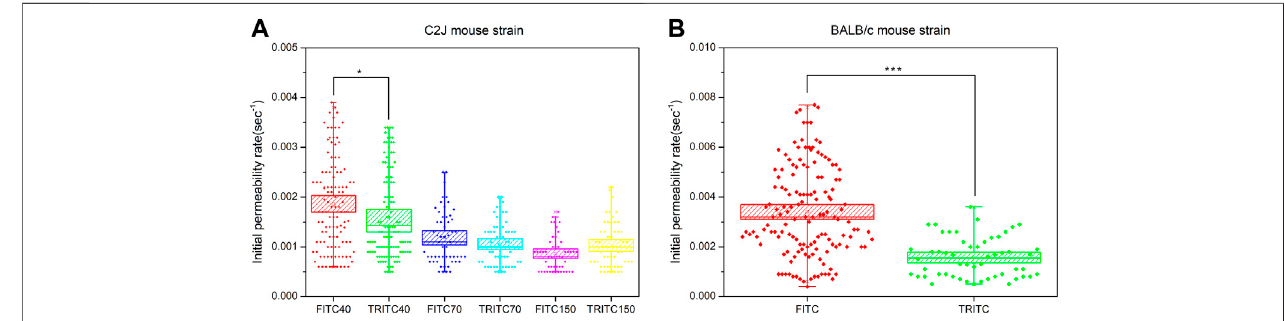
FIGURE 4 | (A) Comparison of the initial permeability rates between FITC-dextran and TRITC-dextran at 40, 70, and 150 kDa in the C2J mouse strain (B) Comparison of initial permeability rates between 40 kDa FITC-dextran and 40 kDa TRITC-dextran in the BALB/c mouse strain. The valid measurement data of each mouse within thesamegroup were merged together togenerate the box chart. The data arepresentedas mean ±SEM.Signi fi cantdifferenceswere analyzed using the one-way ANOVA with Tukey ’ s multiple comparison tests. * p < 0.05, *** p < 0.005.